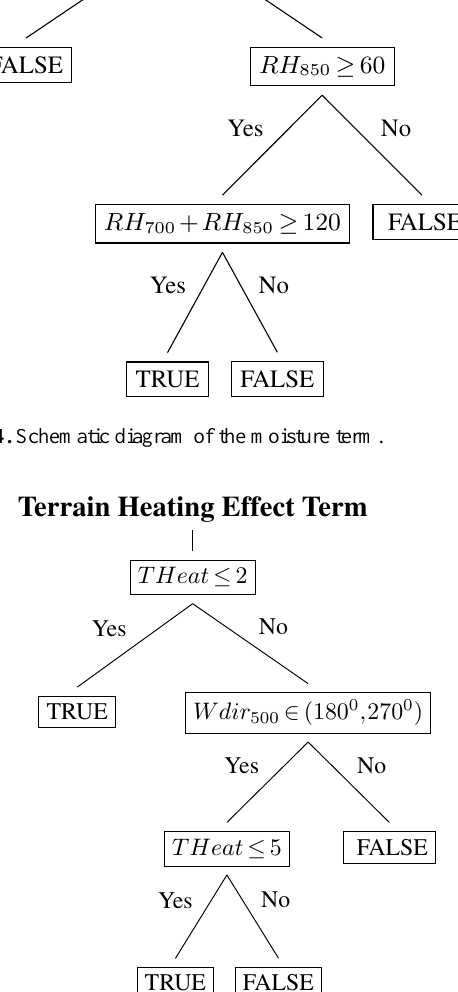
Fig. 6. Schematic diagram of the Locality Term